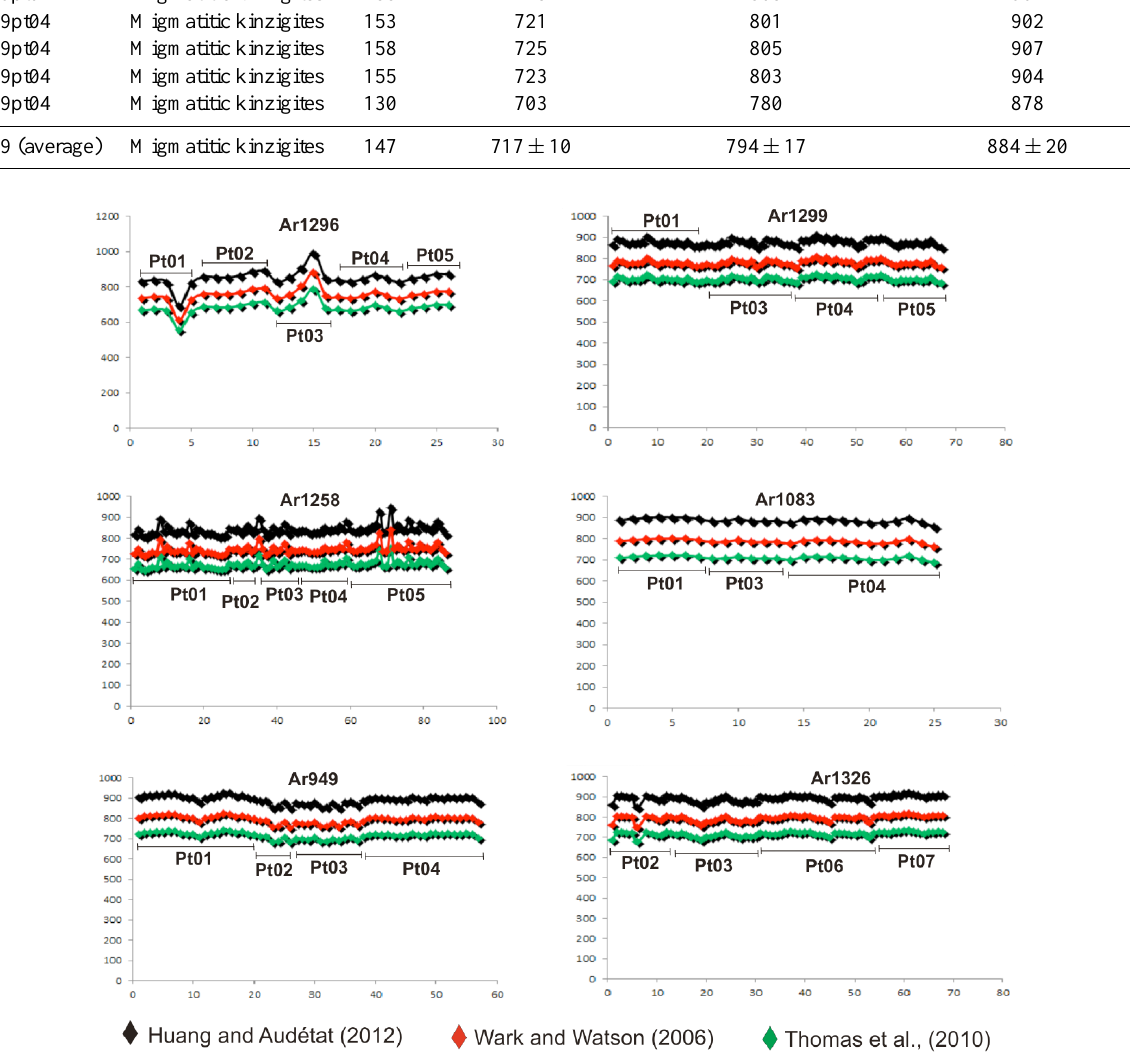
Figure 8. Calculated temperature ( y axis) for each individual TitaniQ analysis ( x axis = analysis number in Table 1) from the calibrations of Huang and Audétat (2012), Thomas et al. (2010) and Wark and Watson (2006).